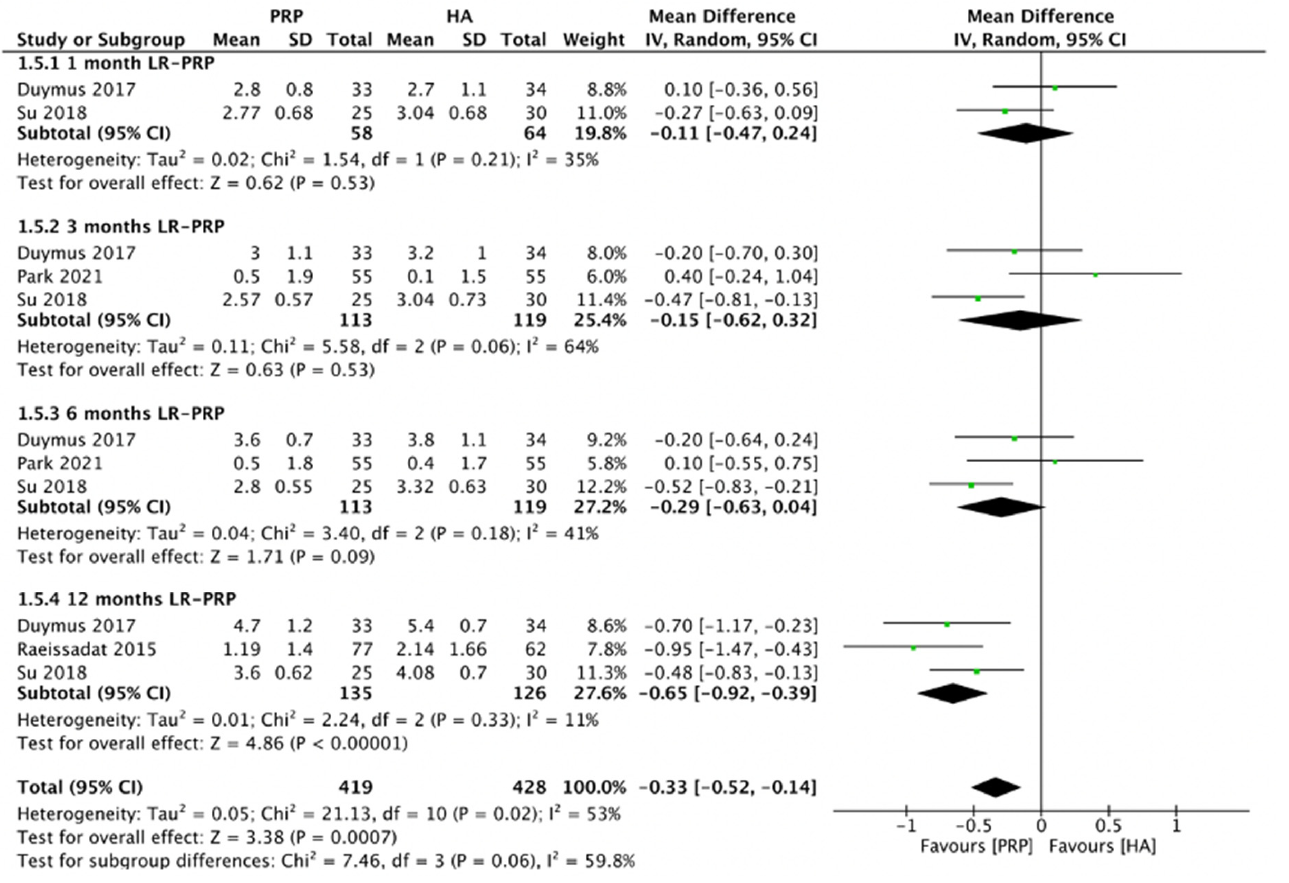
Figure 6. Trials of LR-PRP versus HA. Forest plot of WOMAC stiffness scores. (IV, inverse variance; CI, confidence interval; SD, standard deviation).